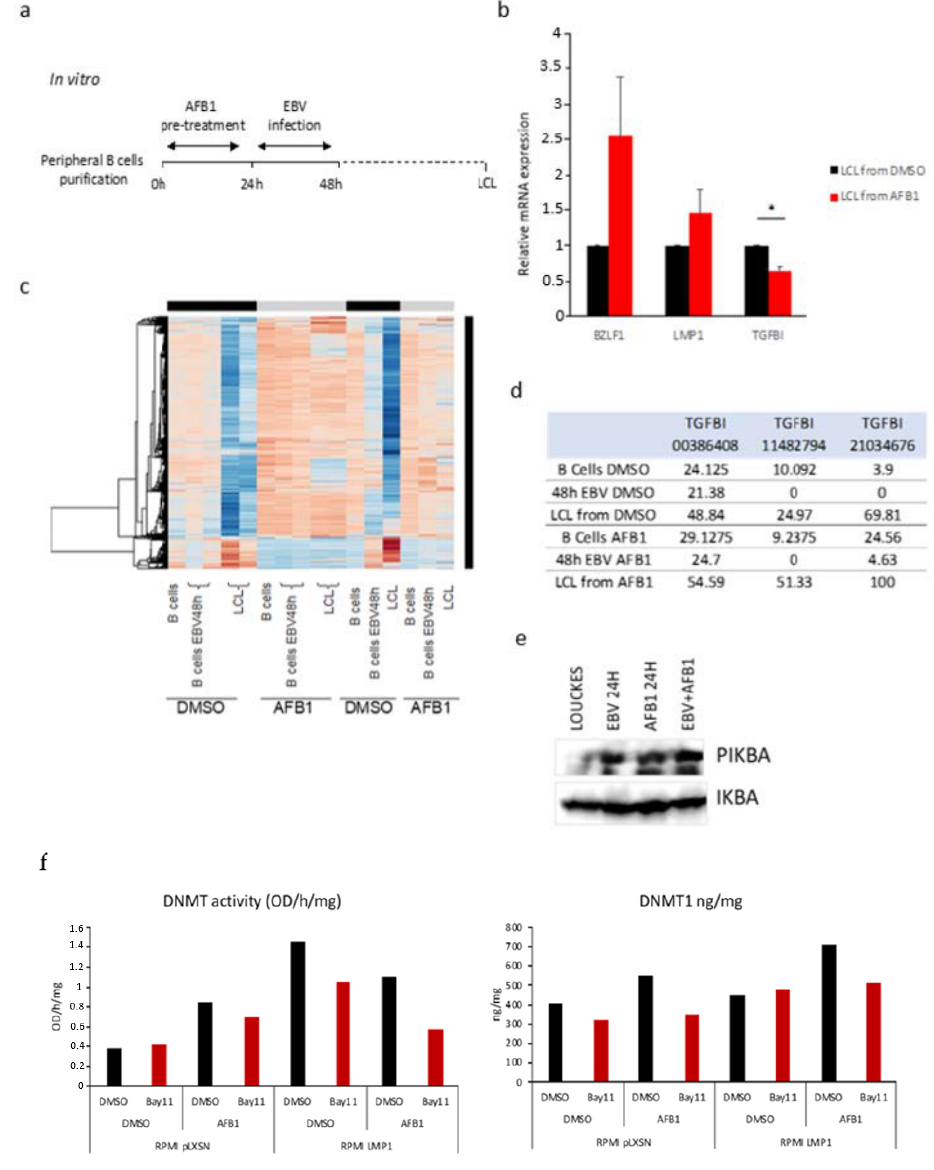
Figure 4. EBV and AFB1 share a common pathway to regulate TGFBI. ( a ) Schematic representation of the in vitro combined AFB1-exposure and EBV-infection-mediated primary B cells immortalization experiment. ( b ) qPCR quantification of TGFBI mRNA expression levels in LCL obtained as explained in ( a ) (* p < 0.05). ( c ) Heatmap of CG methylation levels in B cells at different stages of EBV-mediated immortalization, in presence or absence of concomitant AFB1 in vitro exposure . Independent experiments from different B cells donors. ( d ) pyrosequencing-based analysis of TGFBI methylation levels within the three CpGs of interest at different time points of EBV-induced B cells immortalization with concurrent AFB1/DMSO treatment. ( e ) Immunoblotting quantification of Phospho-I κ B α (PIKBA) and I κ B α (IKBA) levels in Louckes vs. Louckes-EBV treated or not with AFB1 50 µM. ( f ) The enzymatic assays-based measure of DNMTs activity (left graph (OD/h/mg)) and DNMT1 quantity in the nucleus (right graph (ng/mg)) in RPMI-LMP1 vs. RPMI-pLXSN cell lines treated with AFB1/DMSO and with Bay11/DMSO.